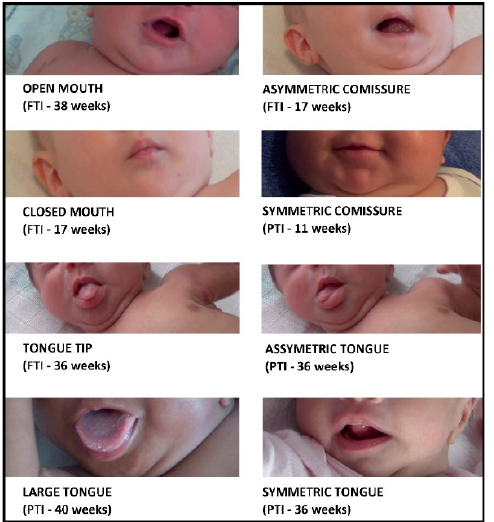
Figure 2. Examples of spontaneous orofacial system movements and postures analyzed in this